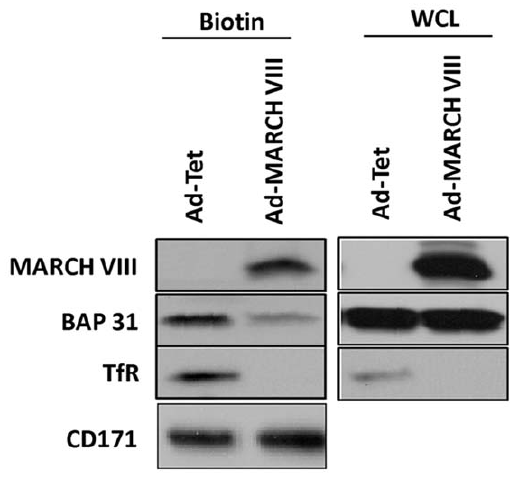
Figure 1. MARCH-VIII reduces surface expression of Bap31. HFF’s were transduced with Ad-Tet and Ad-MARCH-VIII or Ad-Tet alone. 24 hours post-infection, cells were biotinylated. Prior to purification of biotinylated proteins, 100 m l of each sample was removed for analysis of protein expression in each whole cell lysate (WCL). Expression of Bap31 was analyzed in both the biotinylated fraction and the whole cell lysate using immunoblot. Expression of MARCH-VIII and the known MARCH-VIII substrate transferrin receptor (TfR) were included as controls.